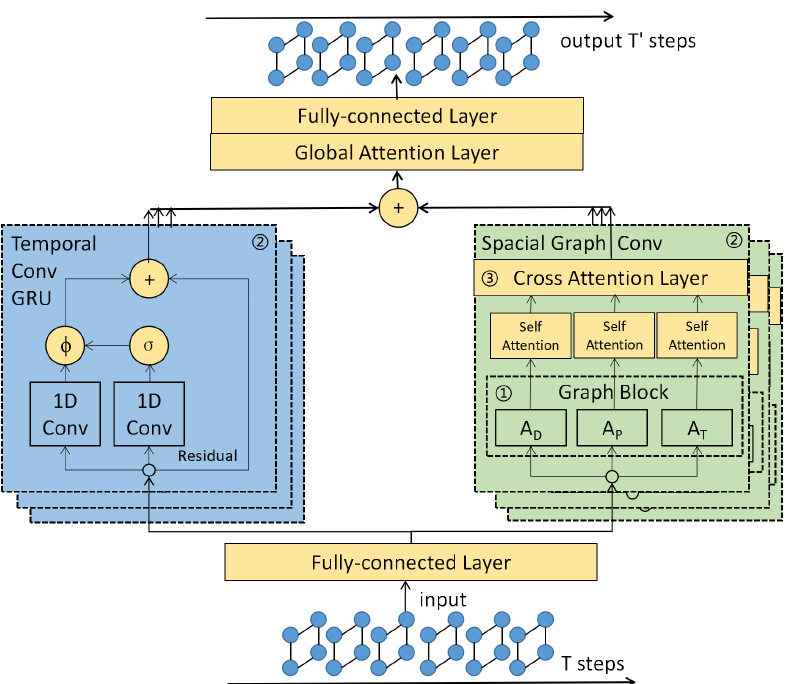
Figure 1. The overall MGCAF framework. Our proposed MGCAF model consists of (1) a multigraph construction mechanism, which consists of distances, position relationships, and temporal correlations as the fundamental building blocks. We use Graph Block to represent the mechanism in the figure; (2) a spatial–temporal feature extractor, which is formed of several GRU and GCN modules to extract spatial–temporal features simultaneously. We use blue and green colors to represent the blocks; and (3) a cross-attention fusion layer is used to fuse the features extracted by the GCN modules. The cross-attention fusion layer is located in the spatial feature extractors, which are represented in yellow in the figure.